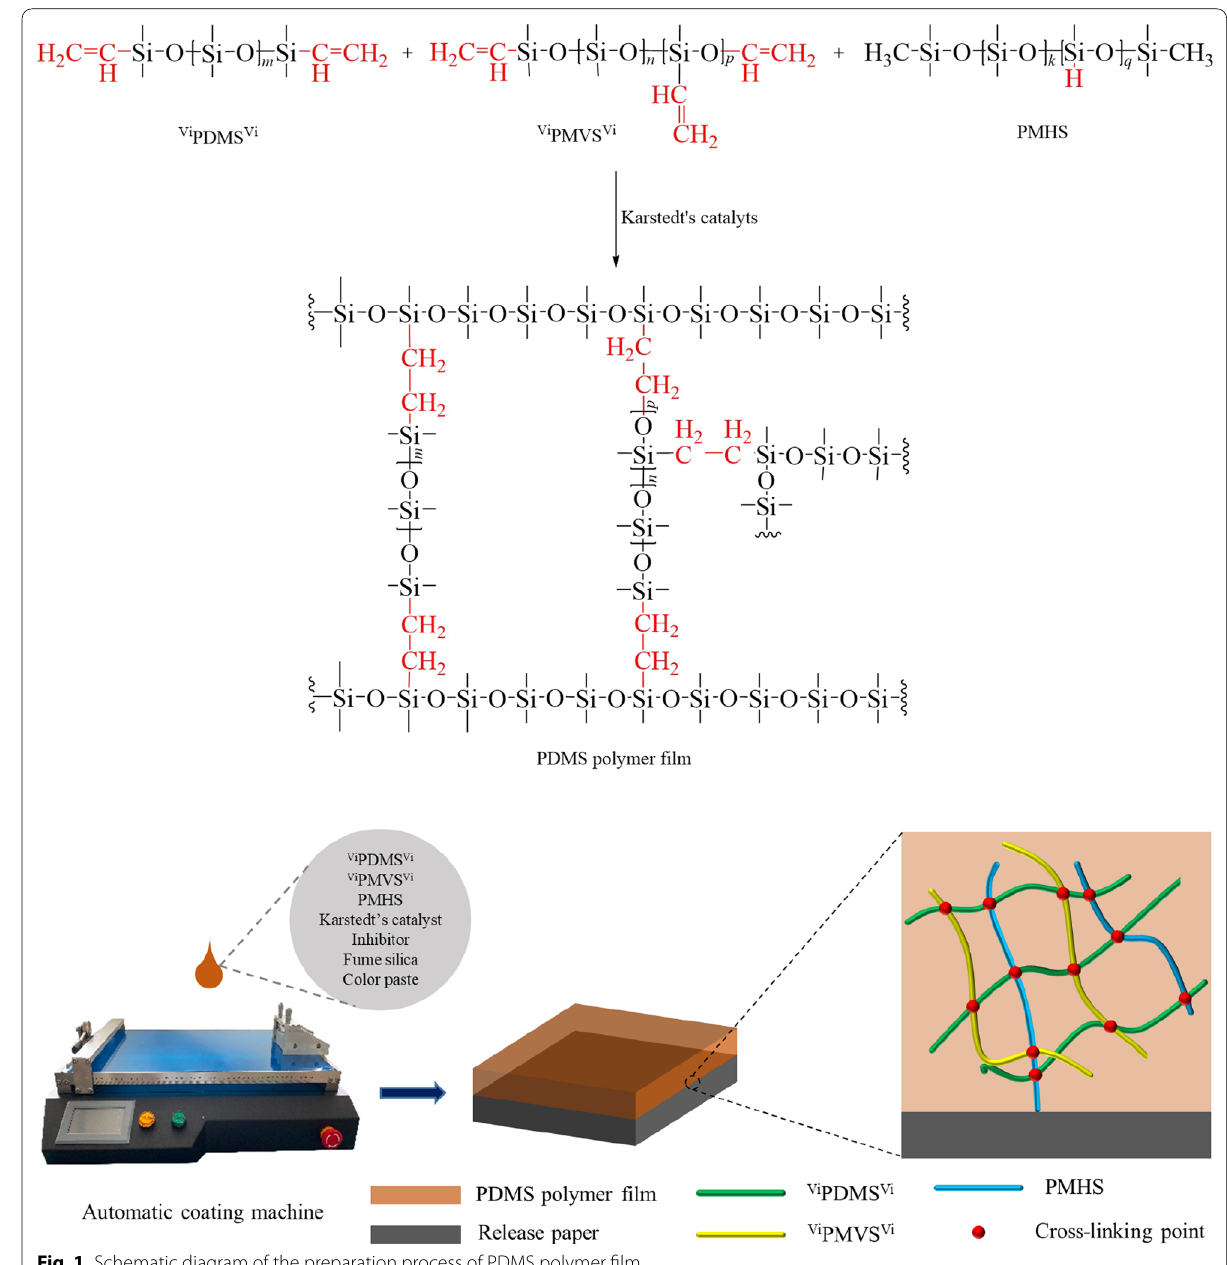
Fig. 1 Schematic diagram of the preparation process of PDMS polymer